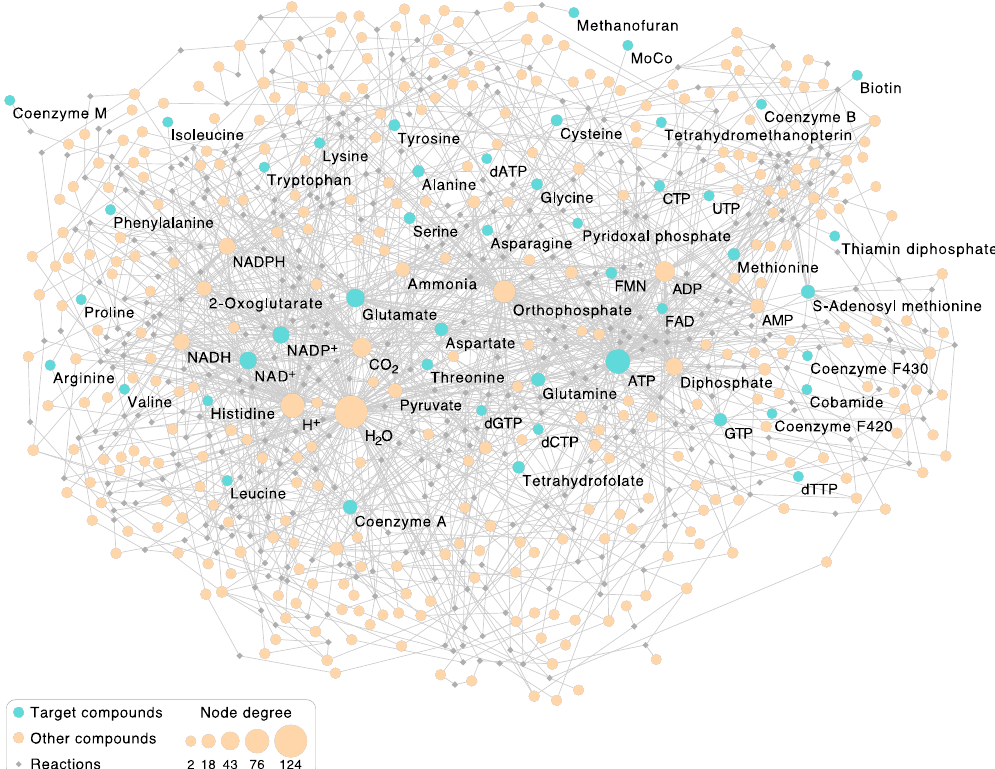
Figure 2. The autotrophic core network of 404 reactions underlying Figure 1. The undirected bipartite graph comprises 404 reaction nodes (displayed as gray diamonds) and 380 compound nodes (circles). The 46 target compounds are colored blue; other compounds involved in the reactions appear orange. Target compounds correspond to the core compounds in Figure 1. Each compound participating in a reaction is connected to the respective reaction node with an edge. Compounds are sized according to node degree (number of reactions the compound takes place in). For example, H 2 O appears either as reactant or product in 125 reactions and is the most frequent compound in the 404 reactions (see also Table 1). In primordial metabolic processes, before the existence of enzymes, a more limited spectrum of compounds than those in Figure 1 was provided by the environment. Compound nodes are labeled if they are targets or if the node degree is ≥ 20. Note that FeS clusters are not included in this figure since their synthesis cannot be reconstructed using KEGG. The network contains only L -amino acids.